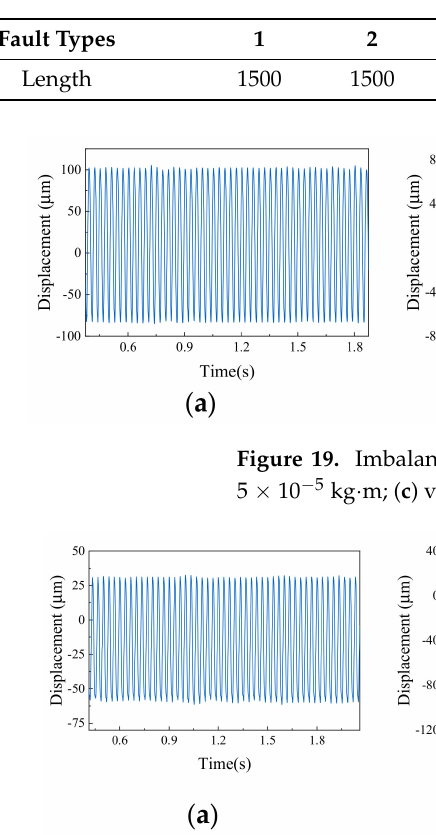
Table 4. Length of sampling faults signal.